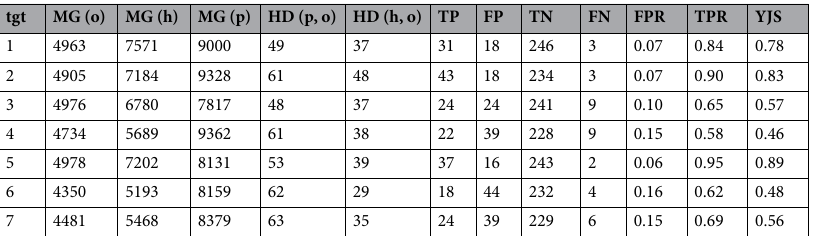
tgt MG (o) MG (h) MG (p) HD (p, o) HD (h, o) TP FP TN FN FPR TPR YJS